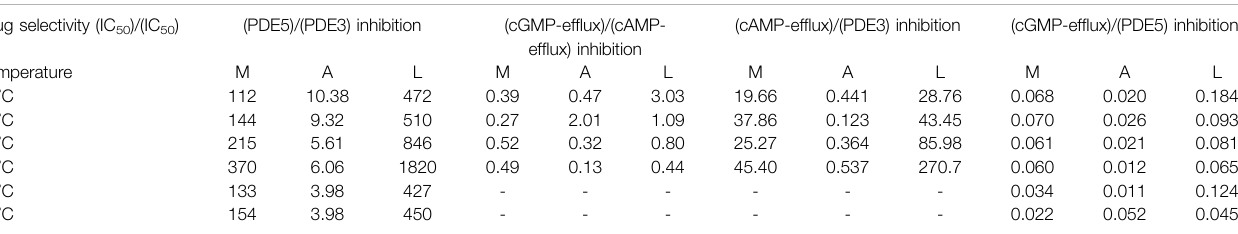
TABLE4| Drugselectivityformilrinone(M),amrinone(A),andlevosimendan(L)attemperaturesrangingfrom37 ° Cto20 ° C.ValuesareratiosbetweenIC 50 -valuesfordifferent elimination ways of cAMP and cGMP. Neither of the drugs inhibited ABCC4-activity below 28 °